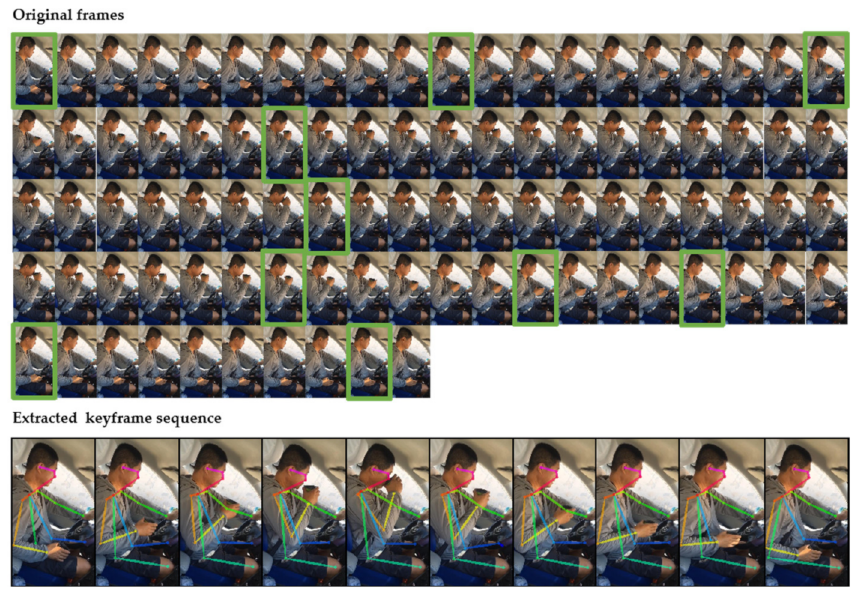
Figure 9. Qualitative results for our proposed keyframe sequences extraction